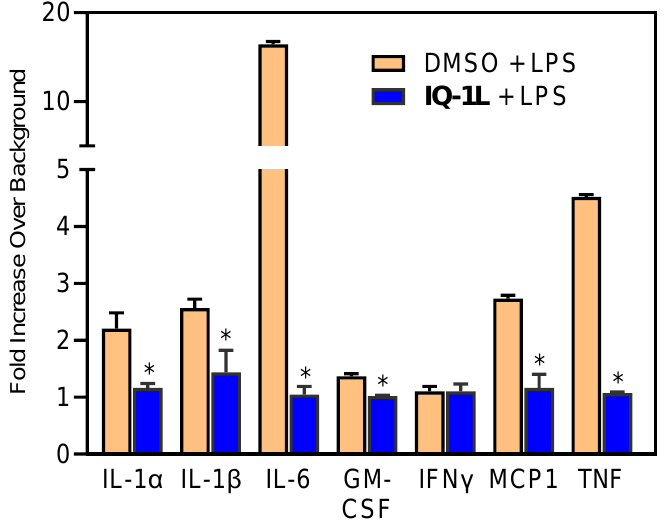
Figure 4. Effect of the IQ-1L on LPS-induced proinflammatory cytokine production in MonoMac-6 cells. Human MonoMac-6 monocytic cells were pretreated with 10 µ M of IQ-1L or 0.5% DMSO for 30 min, followed by addition of 250 ng/mL LPS ( IQ-1L + LPS) or control buffer for 24 h. Production of cytokines in the supernatants was evaluated using a Multiplex human cytokine ELISA kit. The relative level of cytokine production is shown as fold increase over background (DMSO control). * p < 0.01 compared with DMSO + LPS-treated control cells. The data are presented as the mean ± S.D. of triplicate samples from one experiment that is representative of two independent experiments.